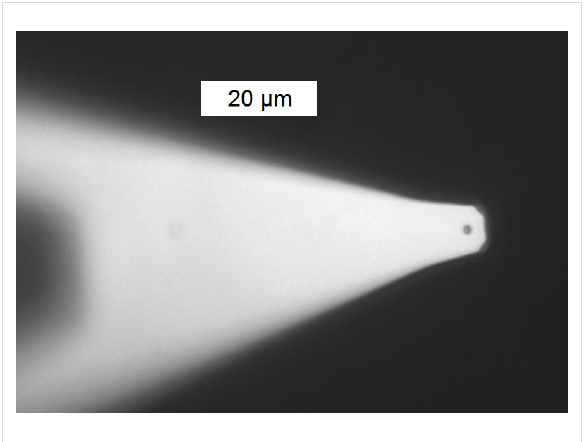
Figure 1: Optical image of a single S. carnosus bacterium immobi- lized by (poly)dopamine on a tipless cantilever.